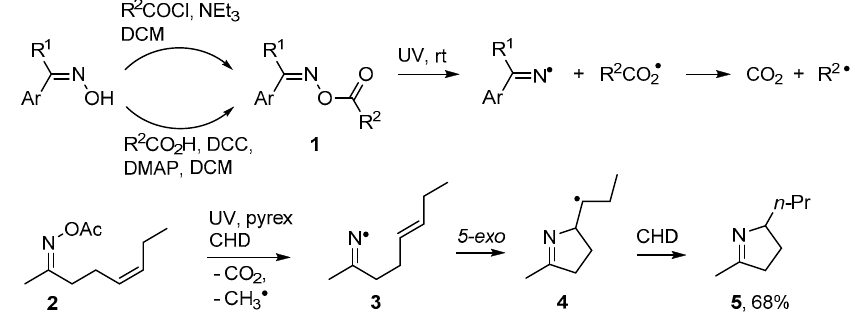
Molecules 2016 , 21 , 660 3 of 23 Scheme 1. Generation of iminyl radicals from oxime derivatives and subsequent ring closures. 2. Syntheses of Dihydropyrroles and Pyrroles Organotin promoted radical methodology is justly famed because it works seamlessly in so many situations and has proved so dependable. Many ingenious syntheses of azaheterocycles have employed organotin hydrides or ditins for the generation of iminyl or aminyl radicals. Zard, for example, described tin hydride-mediated syntheses of dihydropyrroles, indolizidines and other aza-heterocycles from sulfenimines (PhS–N=C<), thionocarbazones and other derivatives [34,35]. Nanni and co-workers generated iminyl radicals by ring closures of C-centred radicals onto organic nitriles and hence prepared many heterocyclic systems. They also employed tin-free thermolytic and other processes [36–38]. Much of this earlier research has been reviewed by Bowman and Aldabbagh [39–41] and/or by Fallis and Brinza [42]. Recently, Zhang and Studer have published an outstanding review of aza-arene syntheses flowing from radical additions to organic isonitriles [43]. This methodology exploits the formation and ring closures of amidoyl radicals (Ar–N=C • –R). 2.1. Pyrrole and Dihydropyrrole Preparations from Carbonyl Oximes Numerous alkaloids contain pyrrole, dihydropyrrole or related rings and many biological roles are associated with these structures [44–46]. Oxime esters 1 can easily be prepared from oximes reacting with either carboxylic acids or acyl halides [47,48]. On photolysis they release an iminyl radical together with an acyloxyl radical and the latter rapidly extrudes CO 2 with production of a C-centred radical [48,49] (Scheme 2). Rodrigues, Sampedro and co-workers used acyl oximes such as 2 as efficient sources of iminyl radicals [50–52]. With this precursor type, the radical co-produced with the iminyl during UV photolyses was acyloxyl [CH 3 CO 2 • ] that simply furnished volatile CH 4 and CO